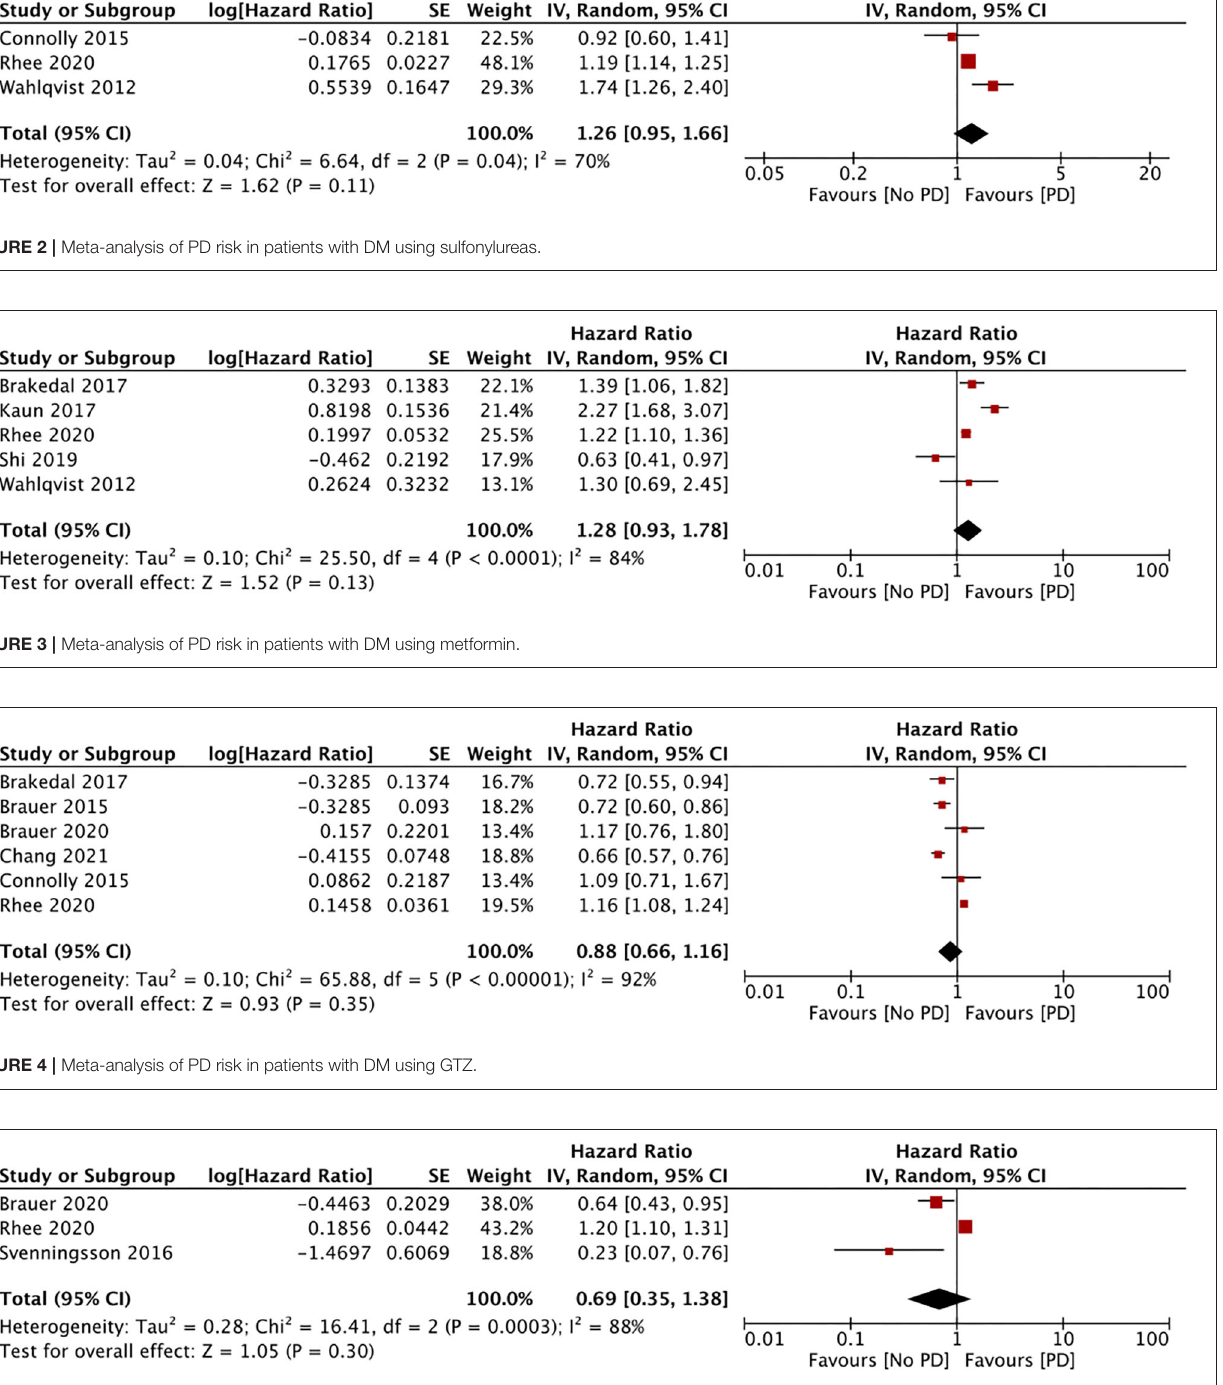
FIGURE 5 | Meta-analysis of PD risk in patients with DM using